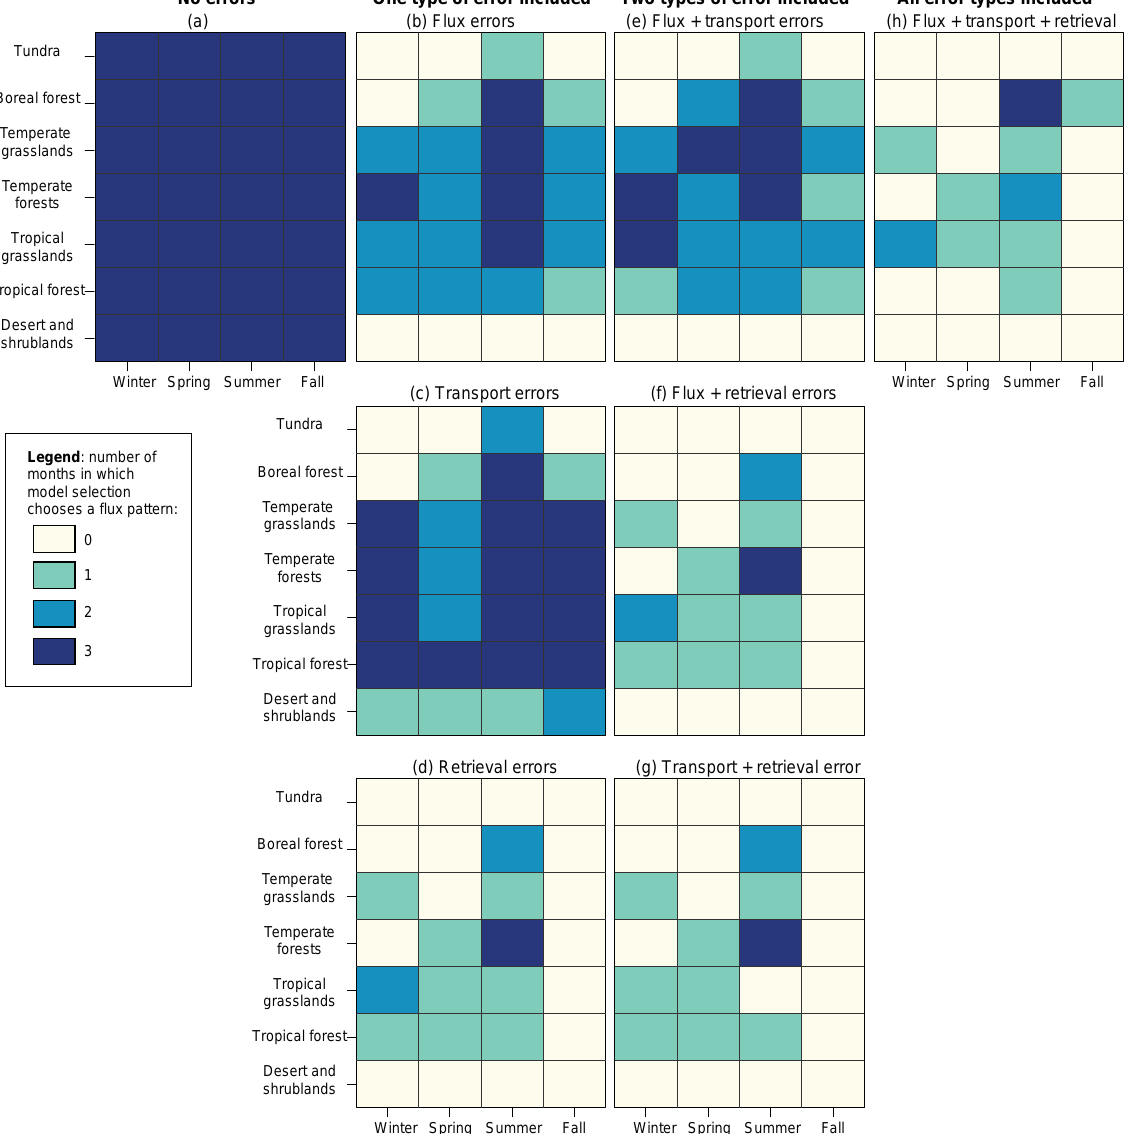
Figure 5. Model selection results for the synthetic data experiments. The first column (a) shows an experiment with no errors in the synthetic observations. The results of that experiment are ideal, and at least one flux pattern is selected in every month and every region using model selection. Subsequent panels (b–h) show the results with one, two, and three types of errors included. Fewer regions and seasons are selected in these experiments. The plot signals that retrieval errors likely play a key